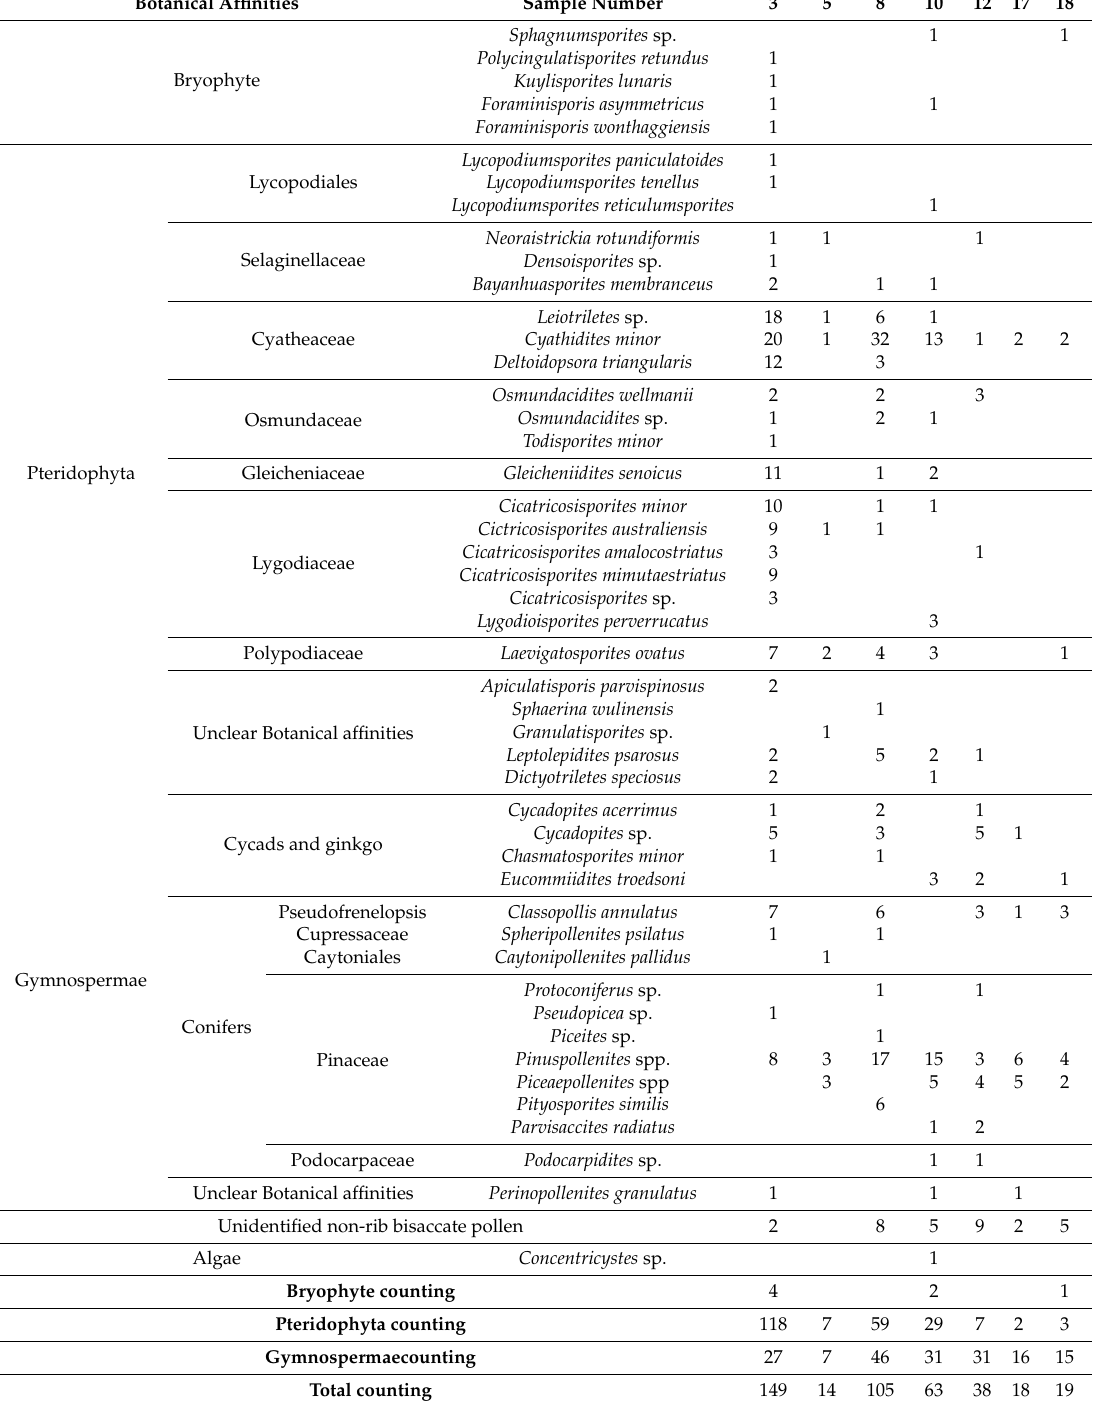
Table 4. Statistics of sporo-pollen in the No.5 coal